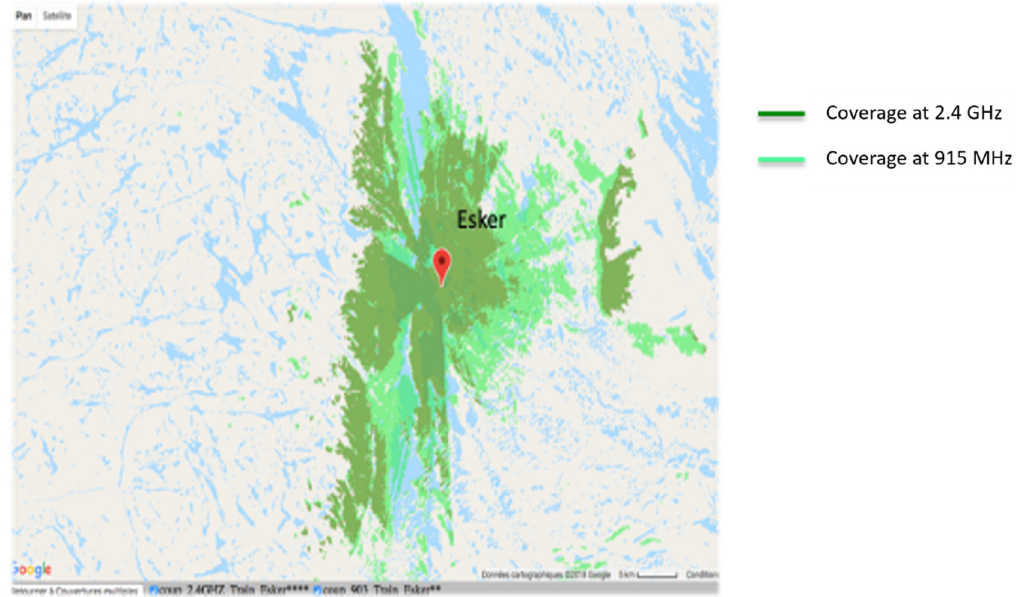
Figure 8. Illustration of the radio coverage simulation at Esker camp (latitude: 53.874178; longitude: − 66.419625) on the railway between Sept-Iles and Schefferville.